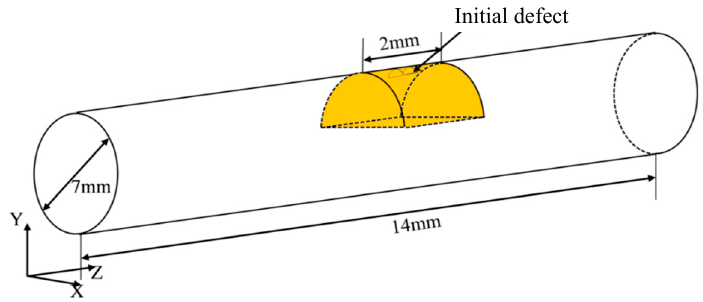
Figure 7. Pre-corroded steel wire model and its size.